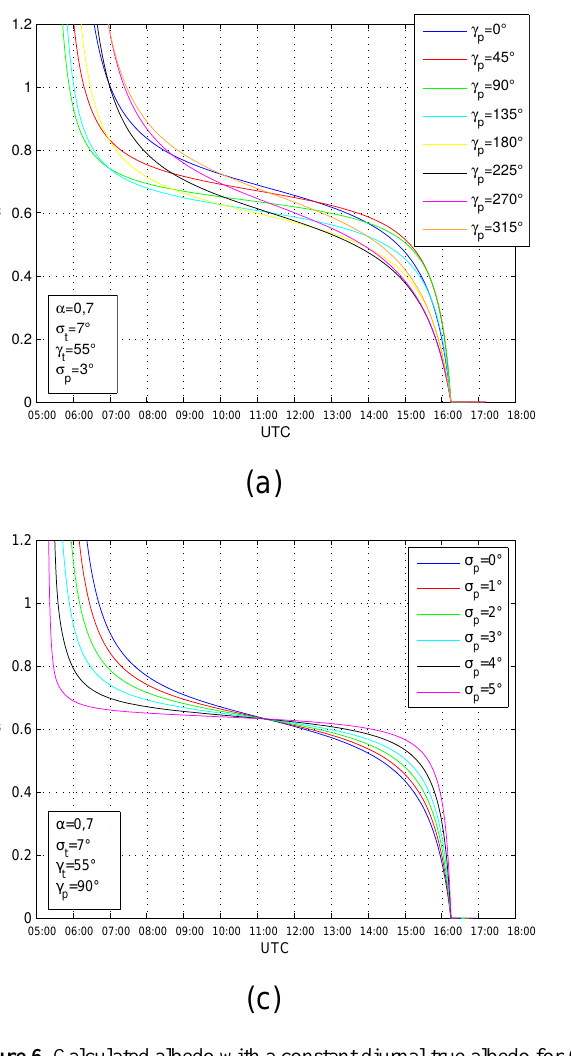
Figure 6. Calculated albedo with a constant diurnal true albedo for ( a and b ) differently oriented ( γ p ) and ( c and d ) inclined ( σ p ) pyranome- ters, different tilted ( σ t ) and directed ( γ t )